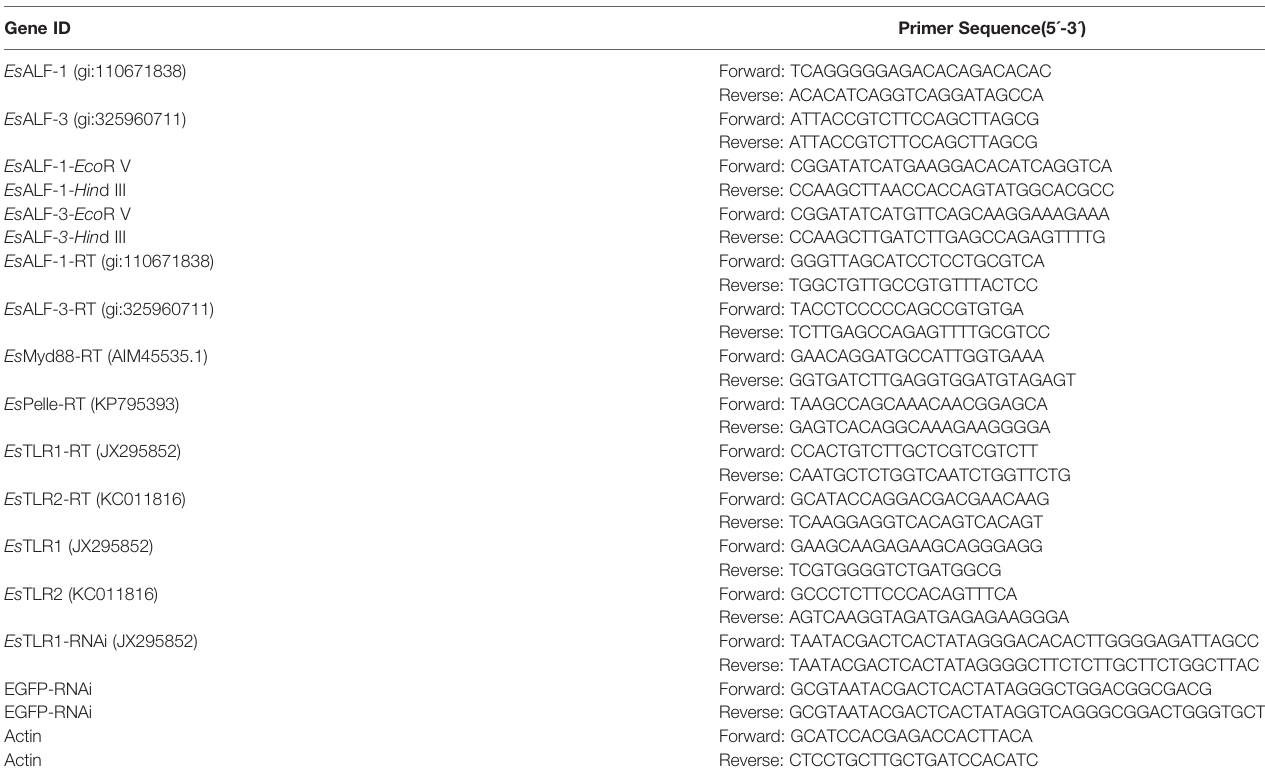
TABLE 1 | Primers used for gene cloning, recombinant expression, RNAi, and Real-time PCR in this study. Gene